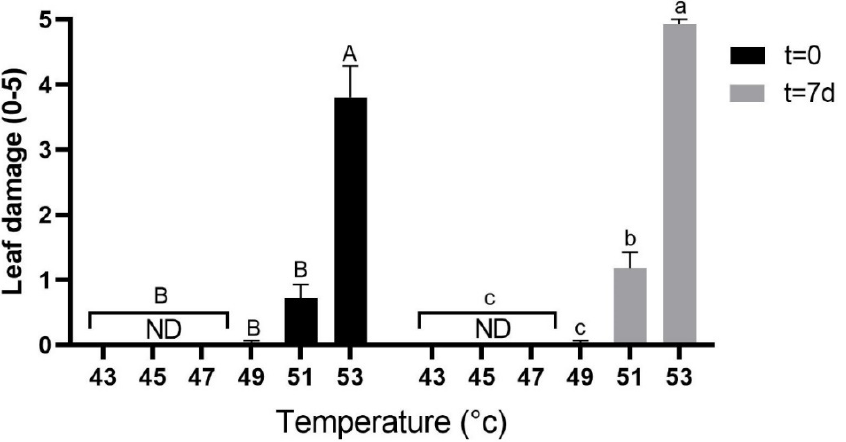
Figure 2. Leaf damage assessment. Leaf damage was assessed and scored on a scale of 0–5, with 0 representing no apparent damage and 5, maximum damage. ND–not detected. Measurements were taken right after climate chamber incubation and before exposure to sunlight (t = 0), and after seven days in the net house (t = 7 d). Each treatment was replicated four times with four different plants for each replicate. Values are means ± SE of at least four different leaves on each of the 16 plants ( n = 16). Columns marked with different letters differ significantly (Tukey-HSD, p < 0.05); uppercase letters for t = 0 and lowercase letters for t = 7 d.